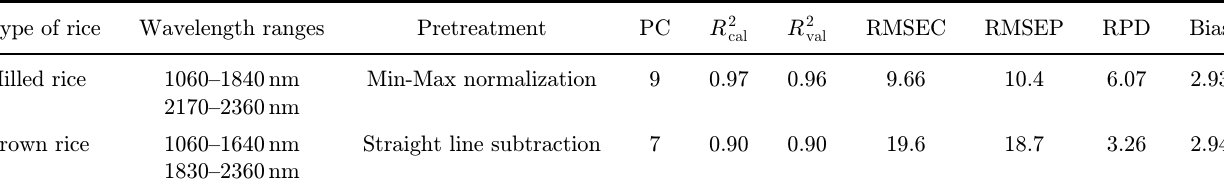
Table 1. The results of PLSR models in estimation of rice weevil populations in milled Hommali rice and brown Hommali rice. Type of